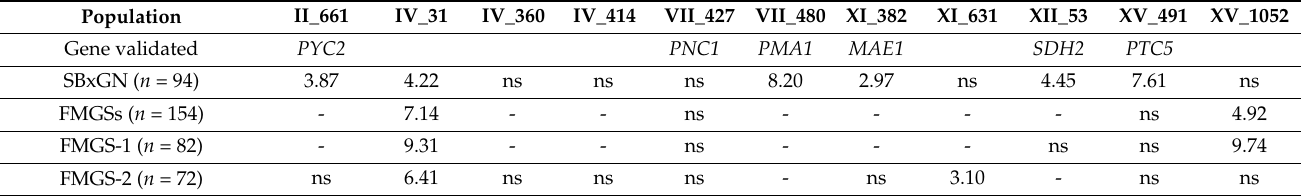
Table 3. QTL penetrance in various populations